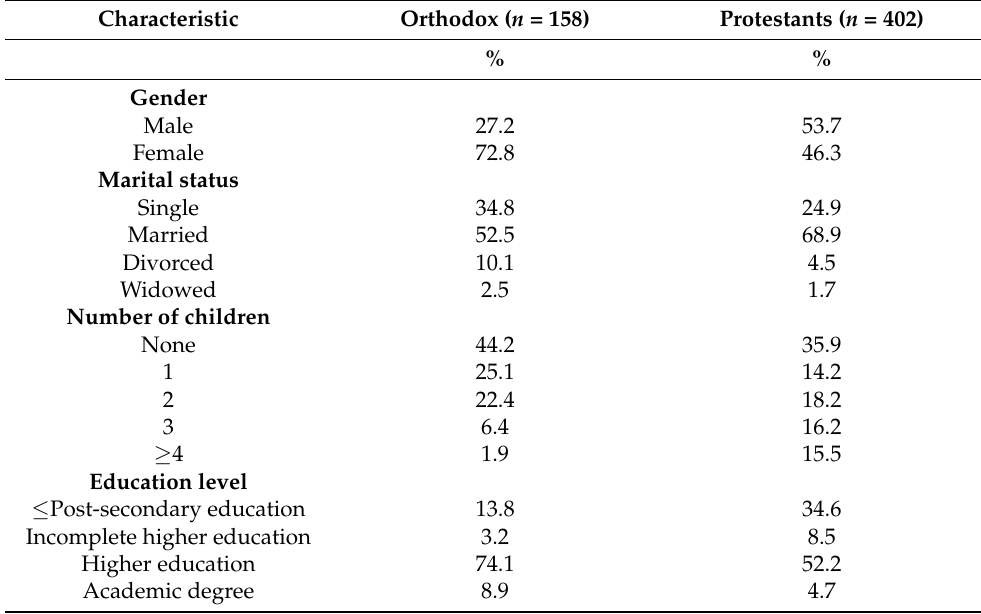
Table 1. Participant characteristics ( n = 560).